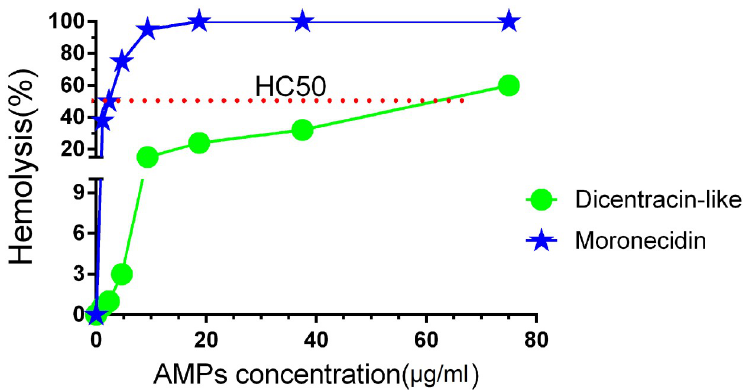
Fig 8. Hemolytic activity of peptides. Hemolysis of human RBCs by moronecidin anddicentracin-like against human RBCs was estimated at various concentration of AMPs. Red line represents HC50 for peptides.